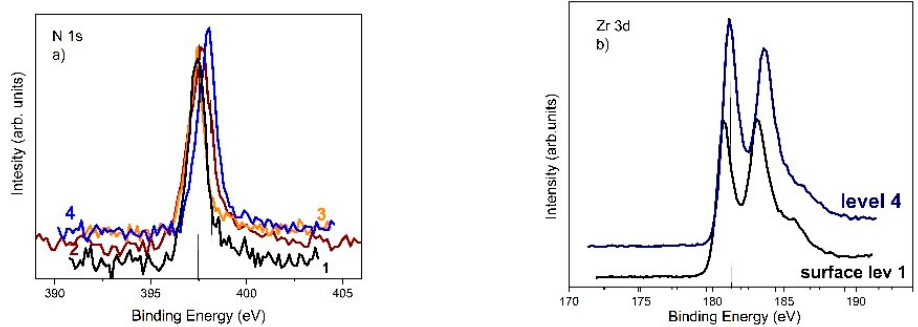
Figure 1. In ( a ) N 1s surface signal (1) is compared with the undersurface correspondent spectra (2,3,4) in sample ZrN A; in ( b ) Zr 3d surface signal has been compared with the in-depth spectra for the same element at level 4, in ZrN